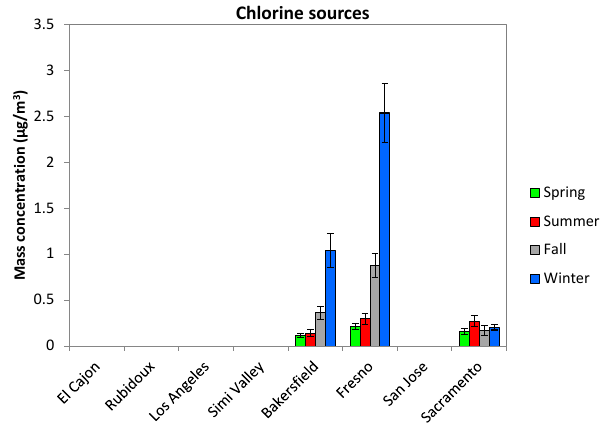
Figure 8. Seasonal average contribution (µgm − 3 ) of chlorine sources to ambient PM 2 . 5 , by site. Error bars correspond to 1 stan- site. Error bars correspond to one standard error. dard